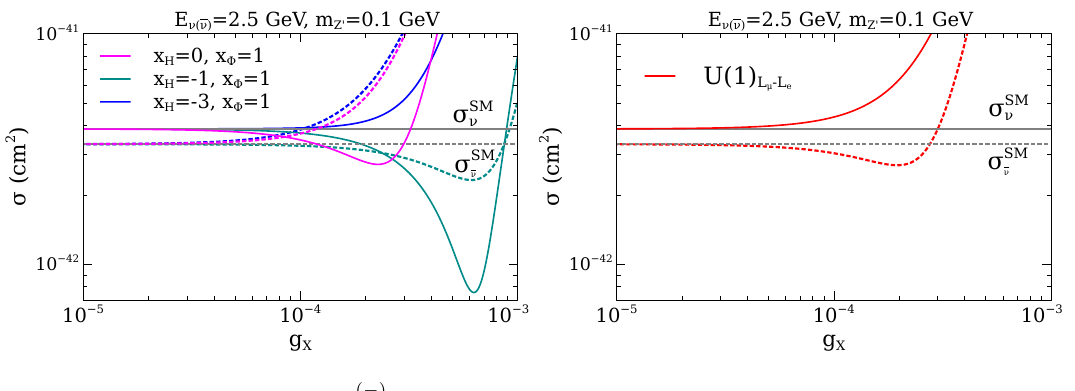
( − ) Figure 2 . Total cross section of ν µ − e scattering for SM and U (1) X scenarios. The solid (dashed) line corresponds to ν µ ( ¯ ν µ ) mode. See text for